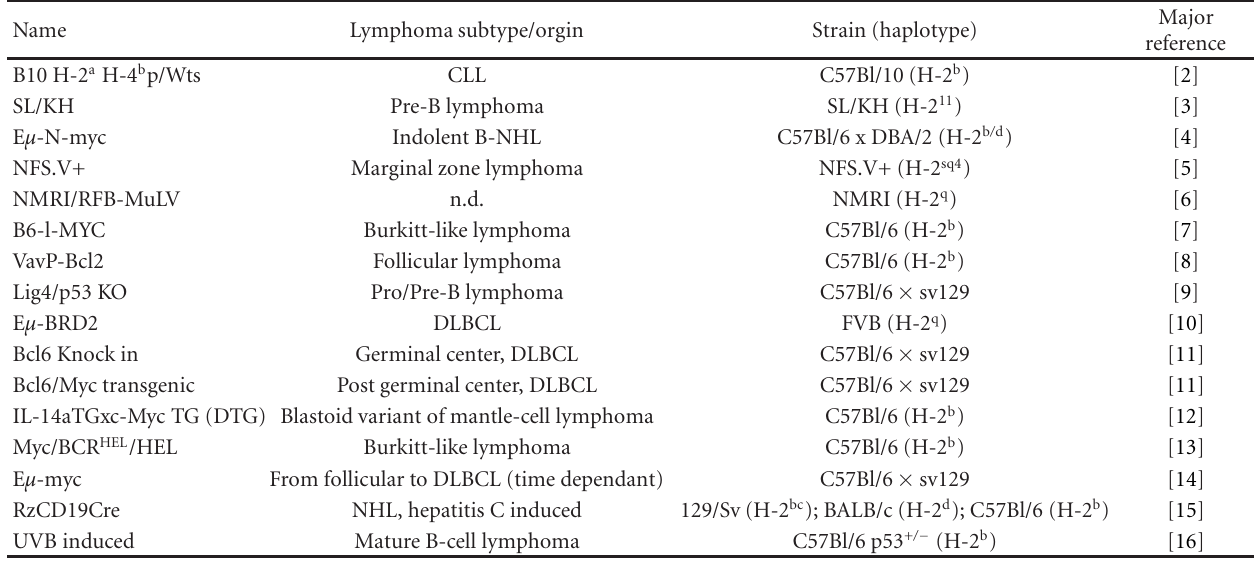
Table 1: Spontaneous models of B-cell lymphoma. B-NHL: non-Hodgkin B-cell lymphoma; CLL: chronic lymphocytic leukemia;